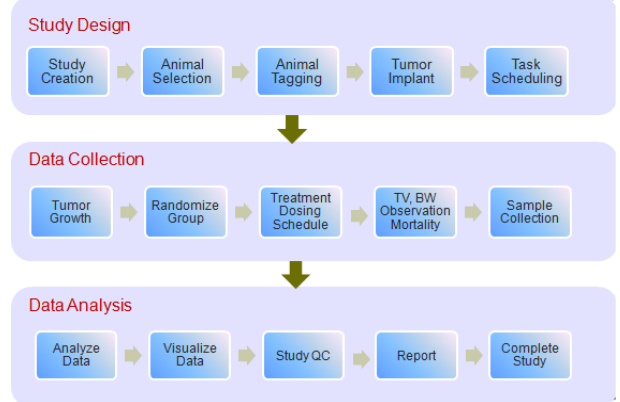
Figure 1: Workflows for in vivo study design, data collection and data analysis.